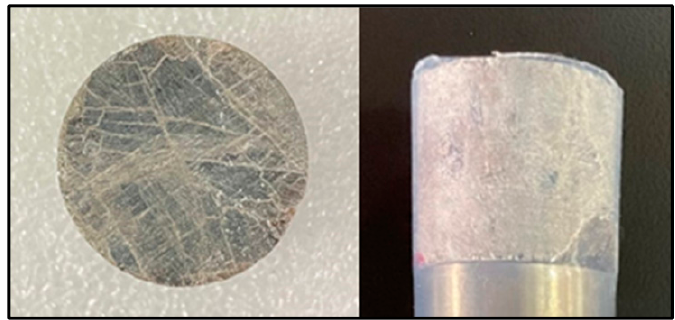
Figure 1. Rock sample for the experiment.